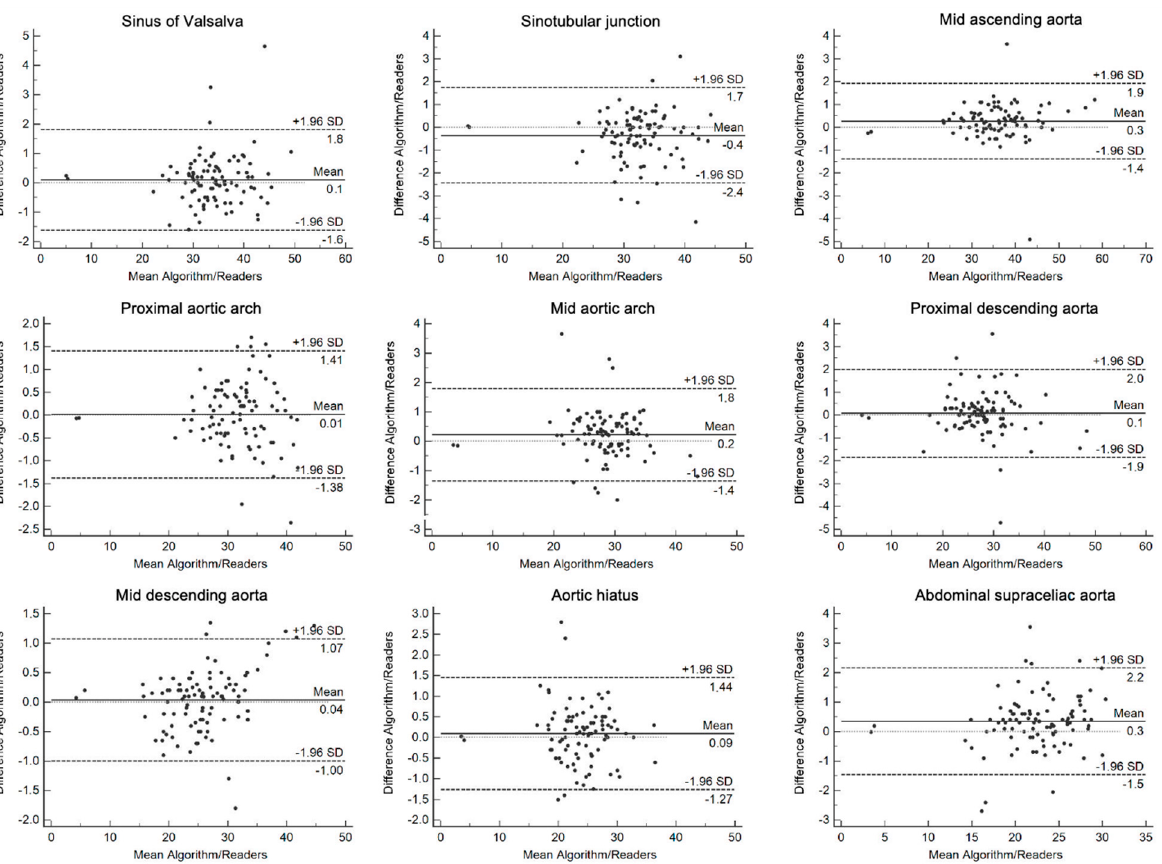
Figure 5. Bland–Altman plots demonstrating the mean bias (solid black line), and upper and lower limits of agreement (dashed black lines) for each measured location by the algorithm and readers along the thoracic aorta. The x- and y-axis are given in millimeters (mm). The measurements between the contrast-enhanced and unenhanced datasets did not significantly differ ( p > 0.05).